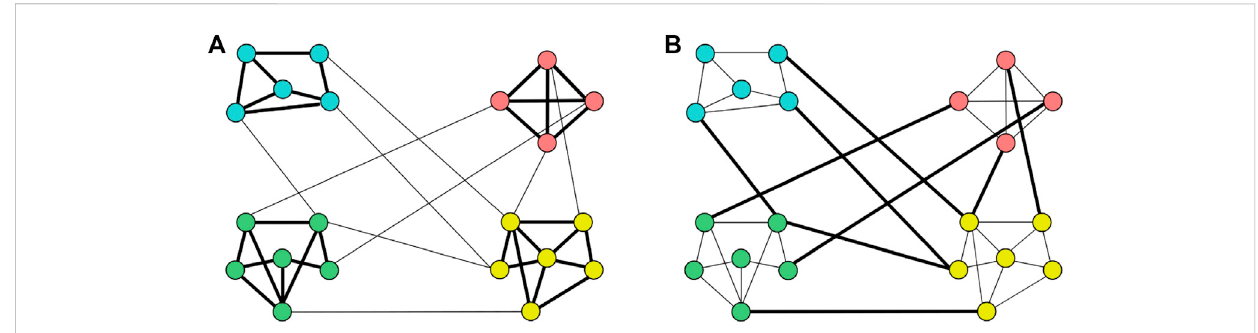
FIGURE 1 (A) Network structure underlying the “ Granovetter weak link hypothesis ” [23]. The thickness of the link indicates its weight, i.e., the intensity of the friendship between the nodes. Links of higher thickness are of higher weight (strong links), and links of lower thickness are of lower weight (weak links). Node color denotes different community memberships, and nodes of the same color are of the same community. The weak link hypothesis depicts a social network in which strong links denoting tight friendship generally occur within people communities, and weak acquaintance links connect distant individualsof differentcommunities. Weak links are important to preserve the cohesiveness of thenetwork. (B) The strong linkhypothesisdepicts a social network in which weak links generally occur within people communities, and strong friendship links connect individuals belonging to different communities. In this case, the strong links are the main players sustaining the cohesiveness of the social